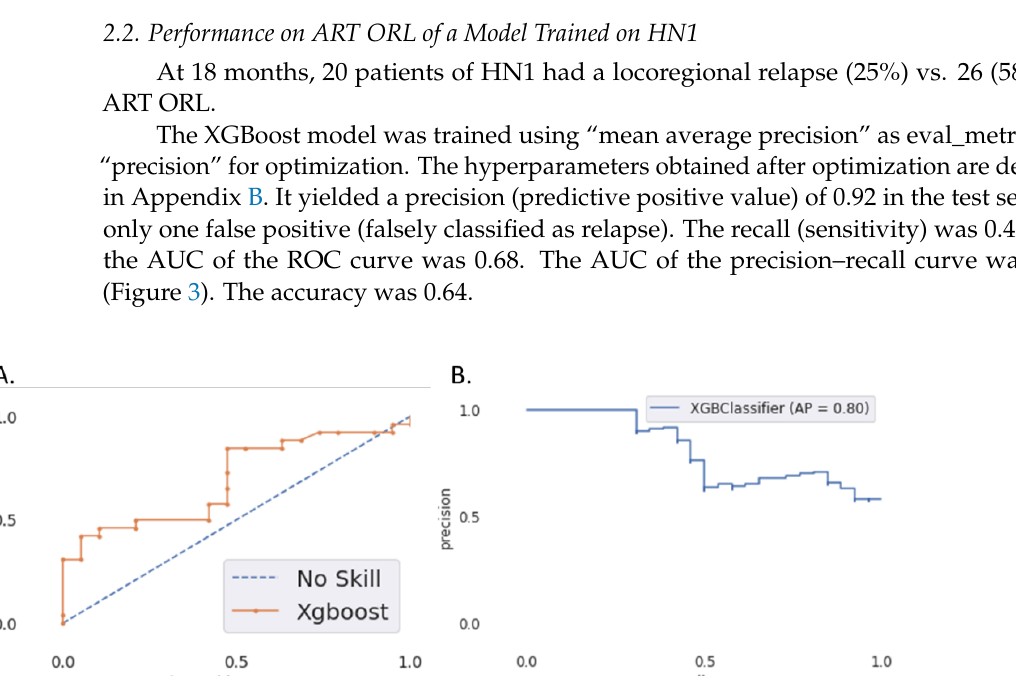
Figure 2. Kaplan Meier estimates, for HN1 and ART ORL cohorts.